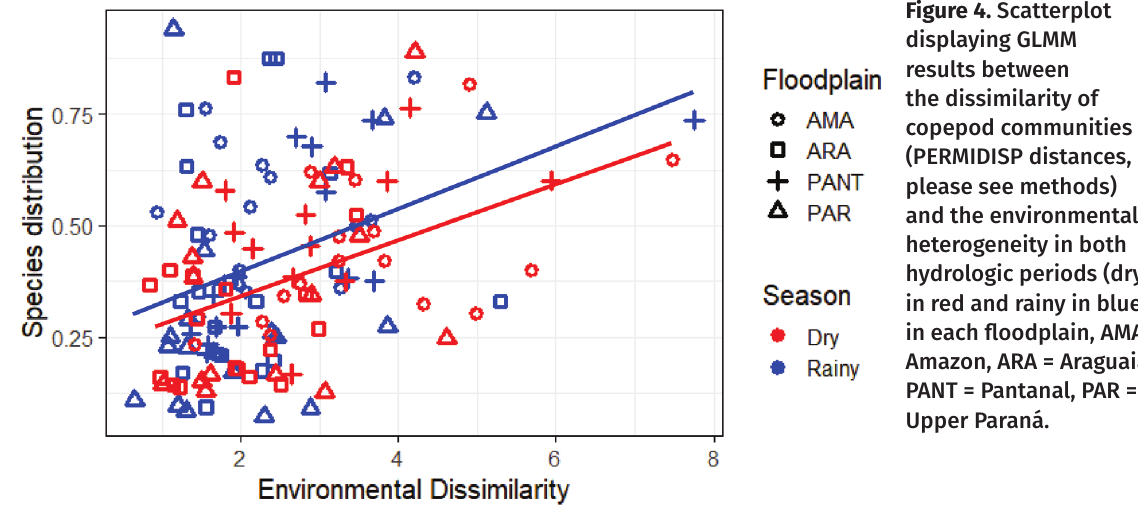
Figure 4. Scatterplot displaying GLMM results